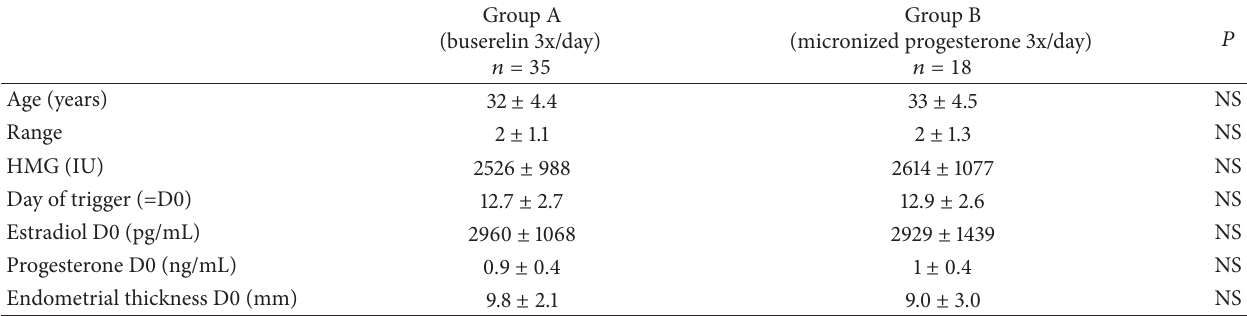
Table 1: Patient demographics and stimulation parameters (mean ±